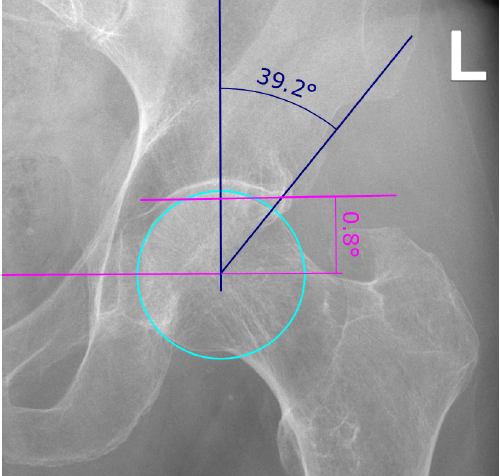
Figure 3. Example of lateral center-edge angle (LCEA) and acetabular index (AI) measurement on an AP pelvic radiograph as described in [13]. The LCEA and AI are a measure for the extent of coverage of the femoral head by the pelvic part of the hip joint, the acetabulum. The LCEA is measured between two lines, both starting in the femoral head center, one vertical line and the line drawn between femoral head center and the most lateral point of the acetabular rim (angle in blue). To find the femoral head center, a circle is drawn (cyan). The vertical line of the LCEA is defined as being perpendicular to the line connecting both femoral head centers (pink). The AI is measured between said pink line connecting both femoral head centers and a line running through the medial edge of the sclerotic acetabular zone and through the lateral sourcil (angle in